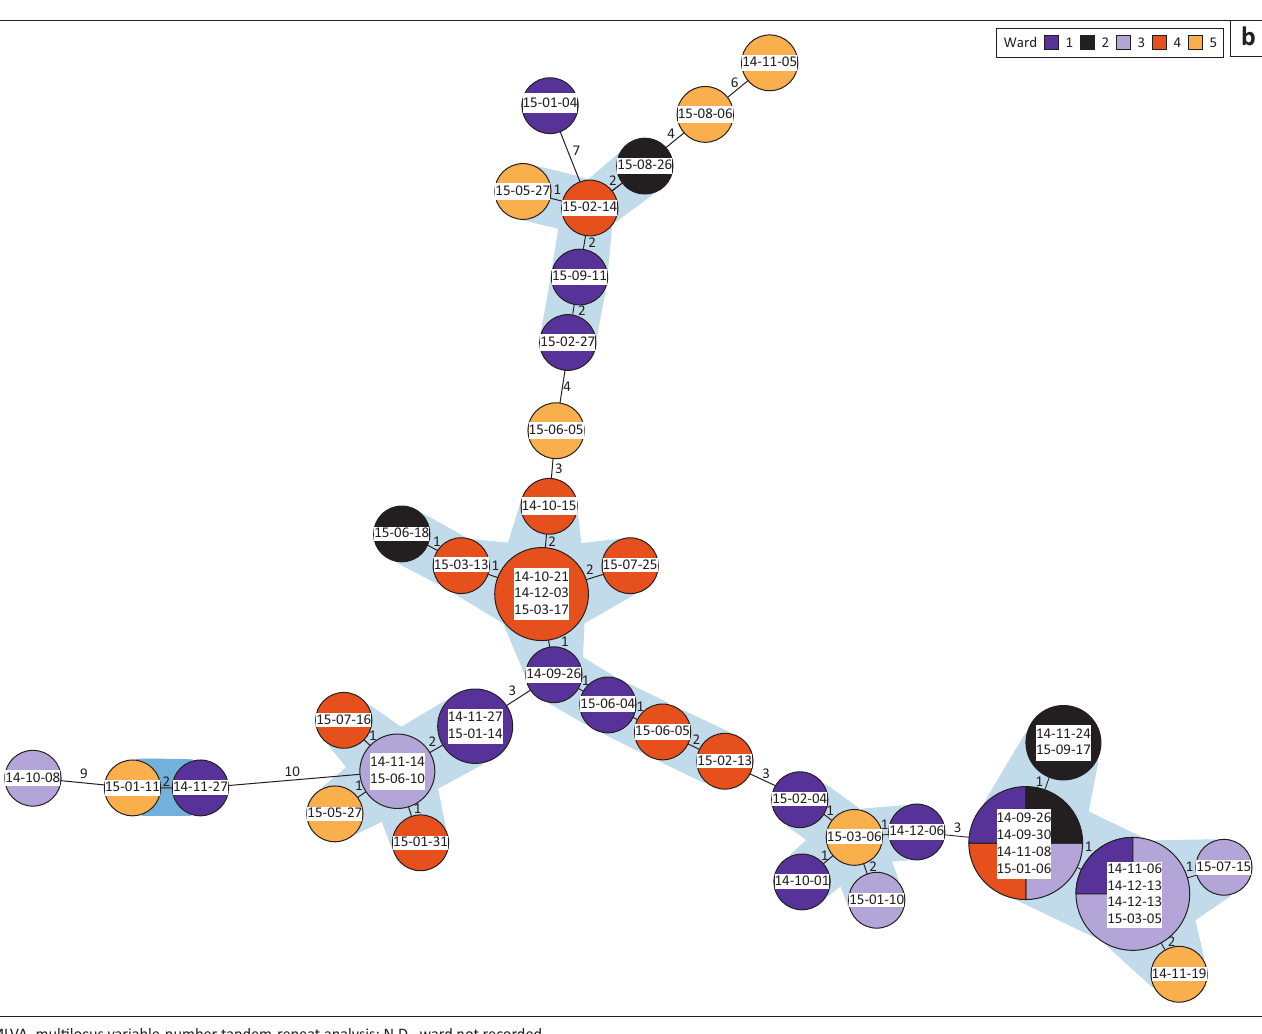
MLVA, multilocus variable-number tandem-repeat analysis; N.D., ward not recorded. FIGURE 3 (Continues...): Minimum spanning tree of MLVA data for C. difficile RT017 isolates showing their clonal relationships and isolation sites. Strains isolated from Hospital A (a) and Hospital B (b) are represented by circles with the date of isolation included in the circle and the circle colour representing the ward that the patient was in at the time of sample submission. Larger circles represent multiple identical isolates, with the size of the circle proportional to the number of isolates. The total summed tandem-repeat difference between strains is given by the numbers between each circle. Clonally related isolates (summed tandem-repeat difference ≤ 2) are grouped within the shaded areas – ( ) pairs, ( ) clusters. The trees have been redrawn for ease of viewing and are not to